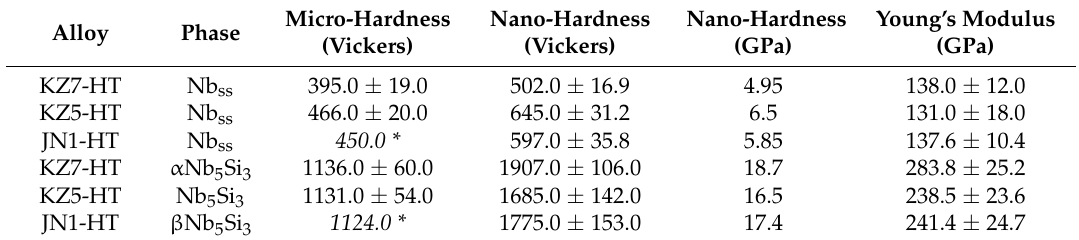
Table 3. Hardness * and Young’s moduli of Nb ss and Nb 5 Si 3 in heat treated Nb-silicide based alloys. Alloy Phase